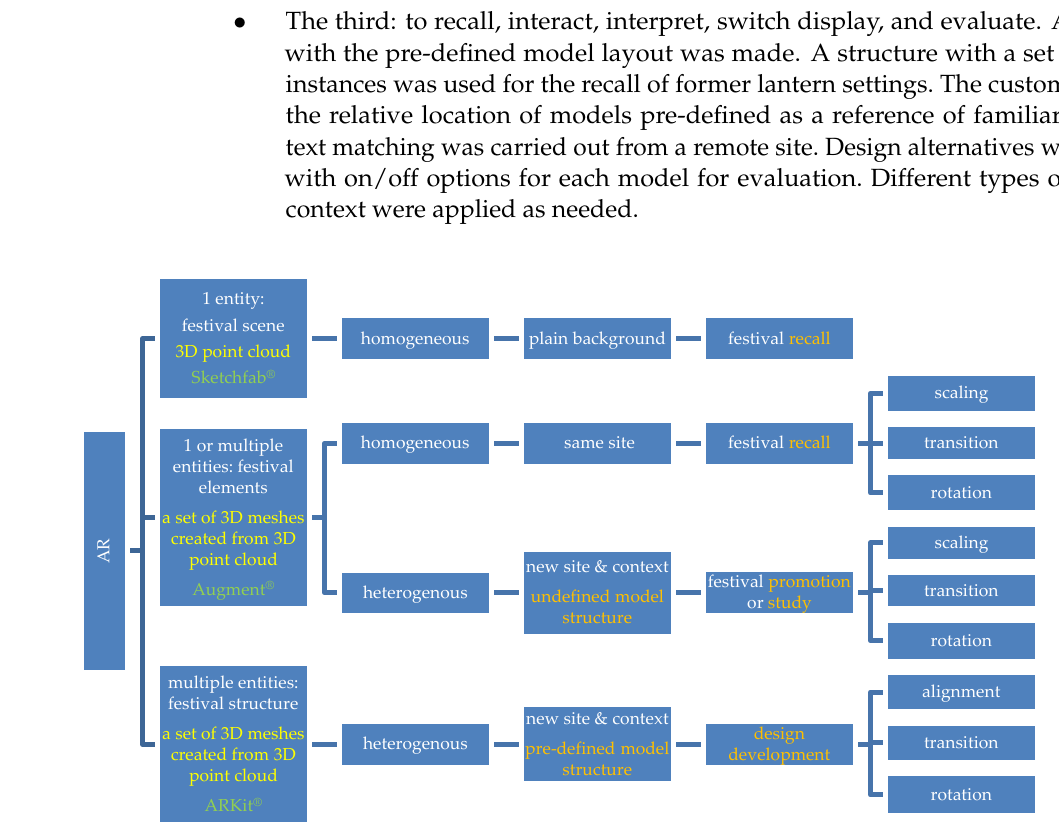
Figure 6. Three scenarios of AR instancing and corresponding data and manipulation.